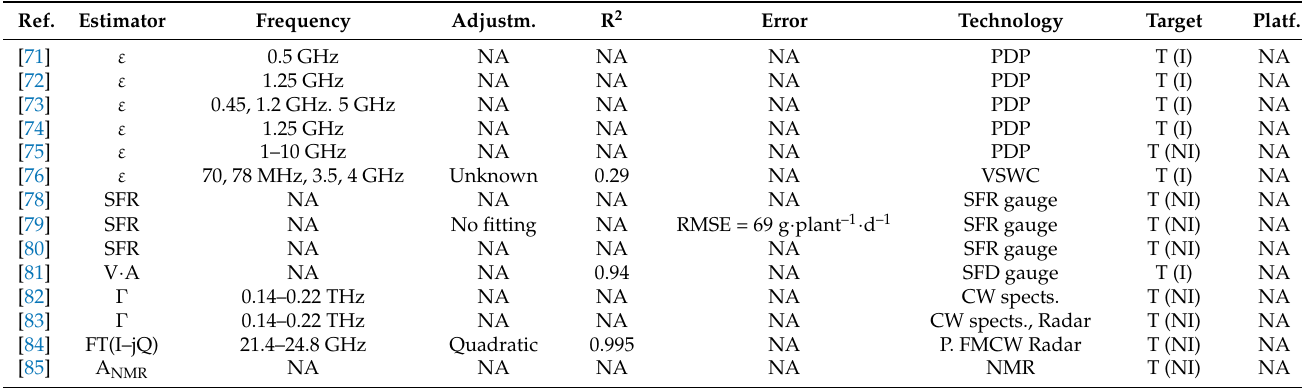
Table 5. Summary of the estimators used in trunk techniques together with the operating frequency, type of adjustment, R 2 , estimation error, technology, target and sensor platform. Ref. Estimator Frequency Adjustm. R 2 Error Technology Target Platf.